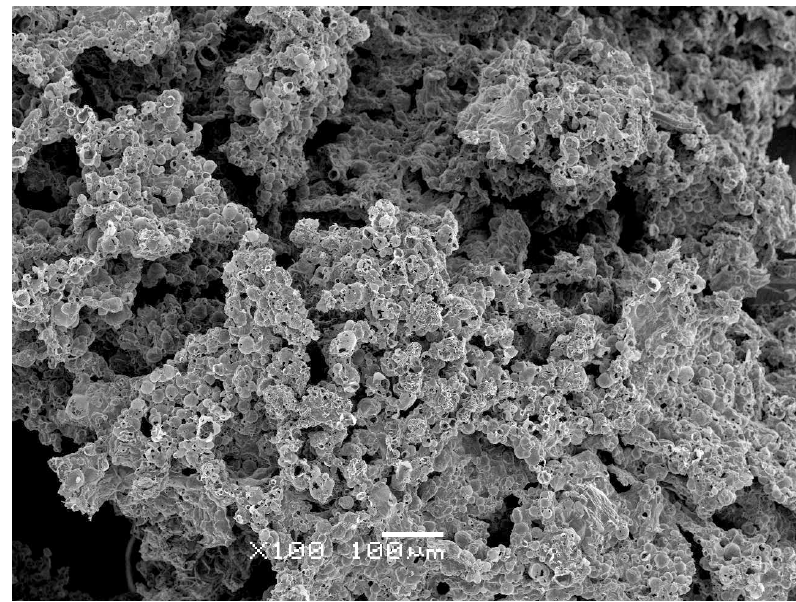
Figure 15. SEM micrograph showing the characteristic foamed morphology of a ABS/PFR char residue after cone calorimeter test.